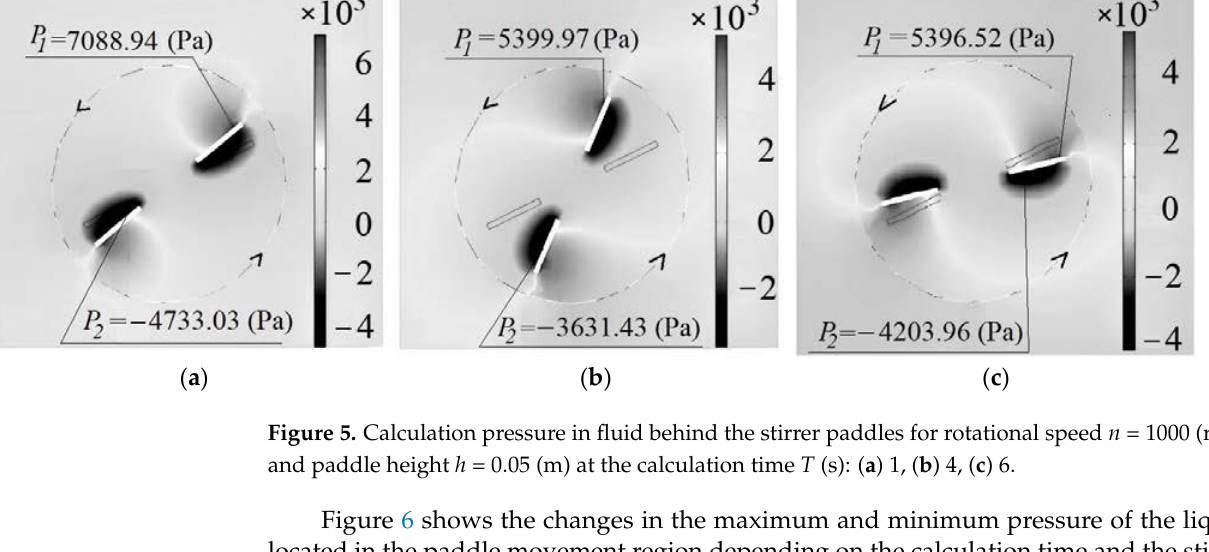
located in the paddle movement region depending on the calculation time and the stirrer rotational speed.